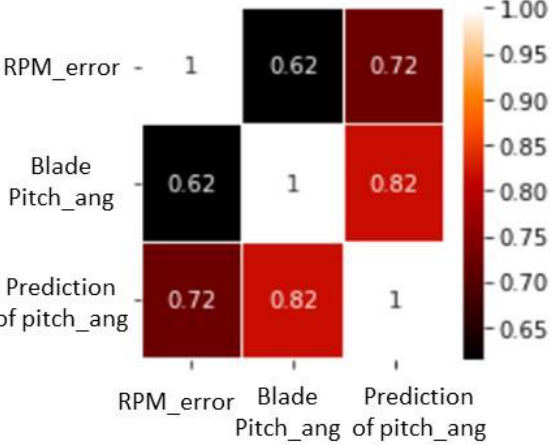
Figure 9. Data correlation matrix used to drive the deep learning algorithm.